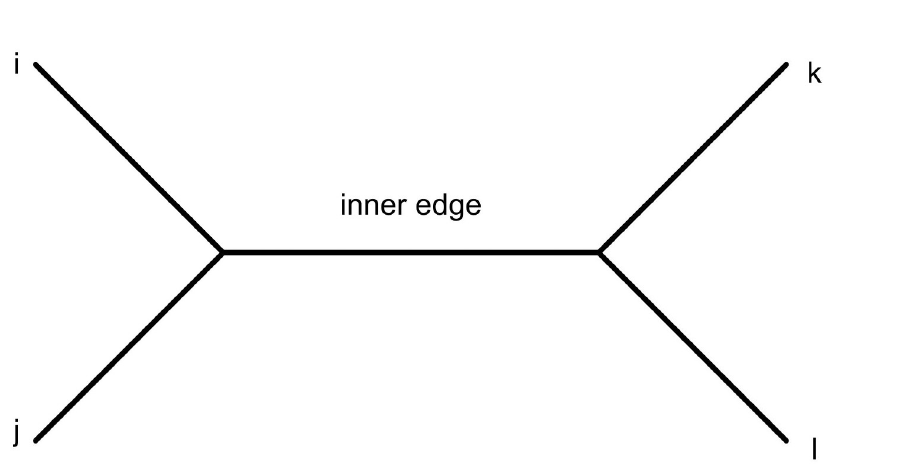
Fig 11. For the given T , l h T ( d , e ) = 2, h T ( b , c ) = 1.